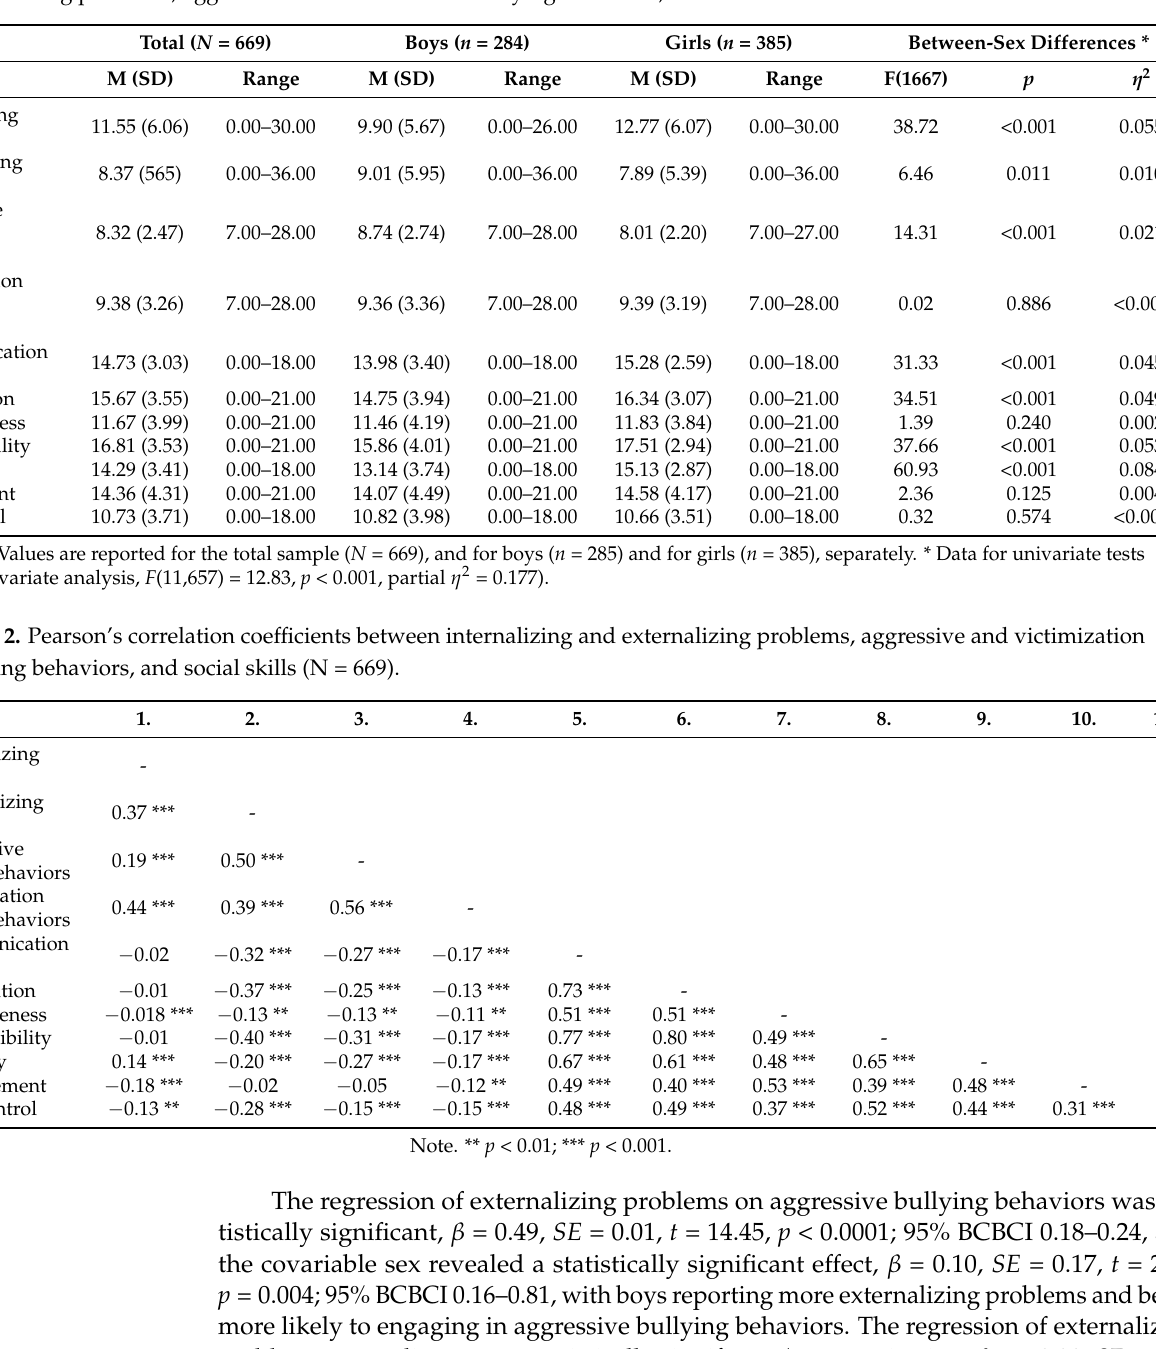
Table 1. Means, standard deviations, and range values, as well as between-sex differences results for internalizing and externalizing problems, aggressive and victimization bullying behaviors, and social skills.